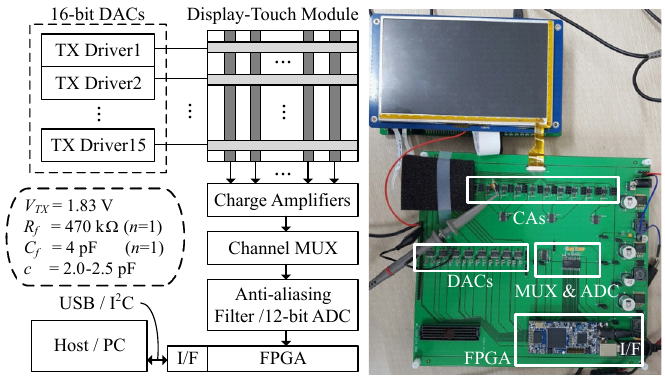
Figure 10. Experimental